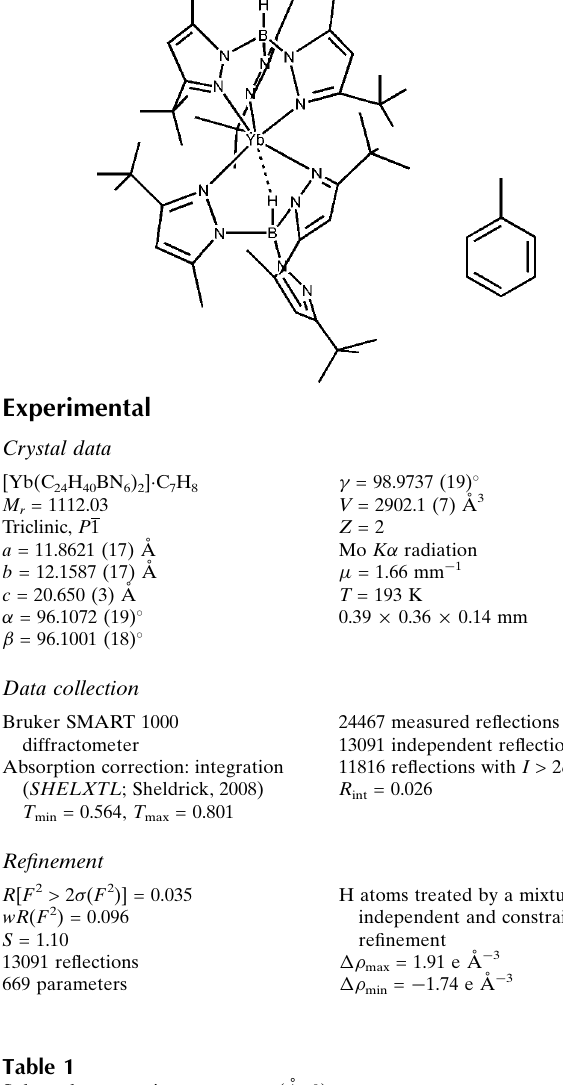
Selected geometric parameters (A˚ , (cid:2) ).